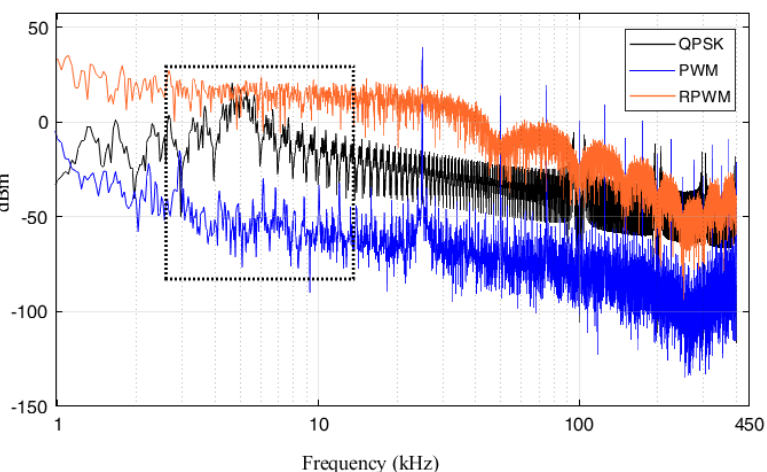
Figure 11. Bit error rate: PWM (blue) versus RPWM (orange).